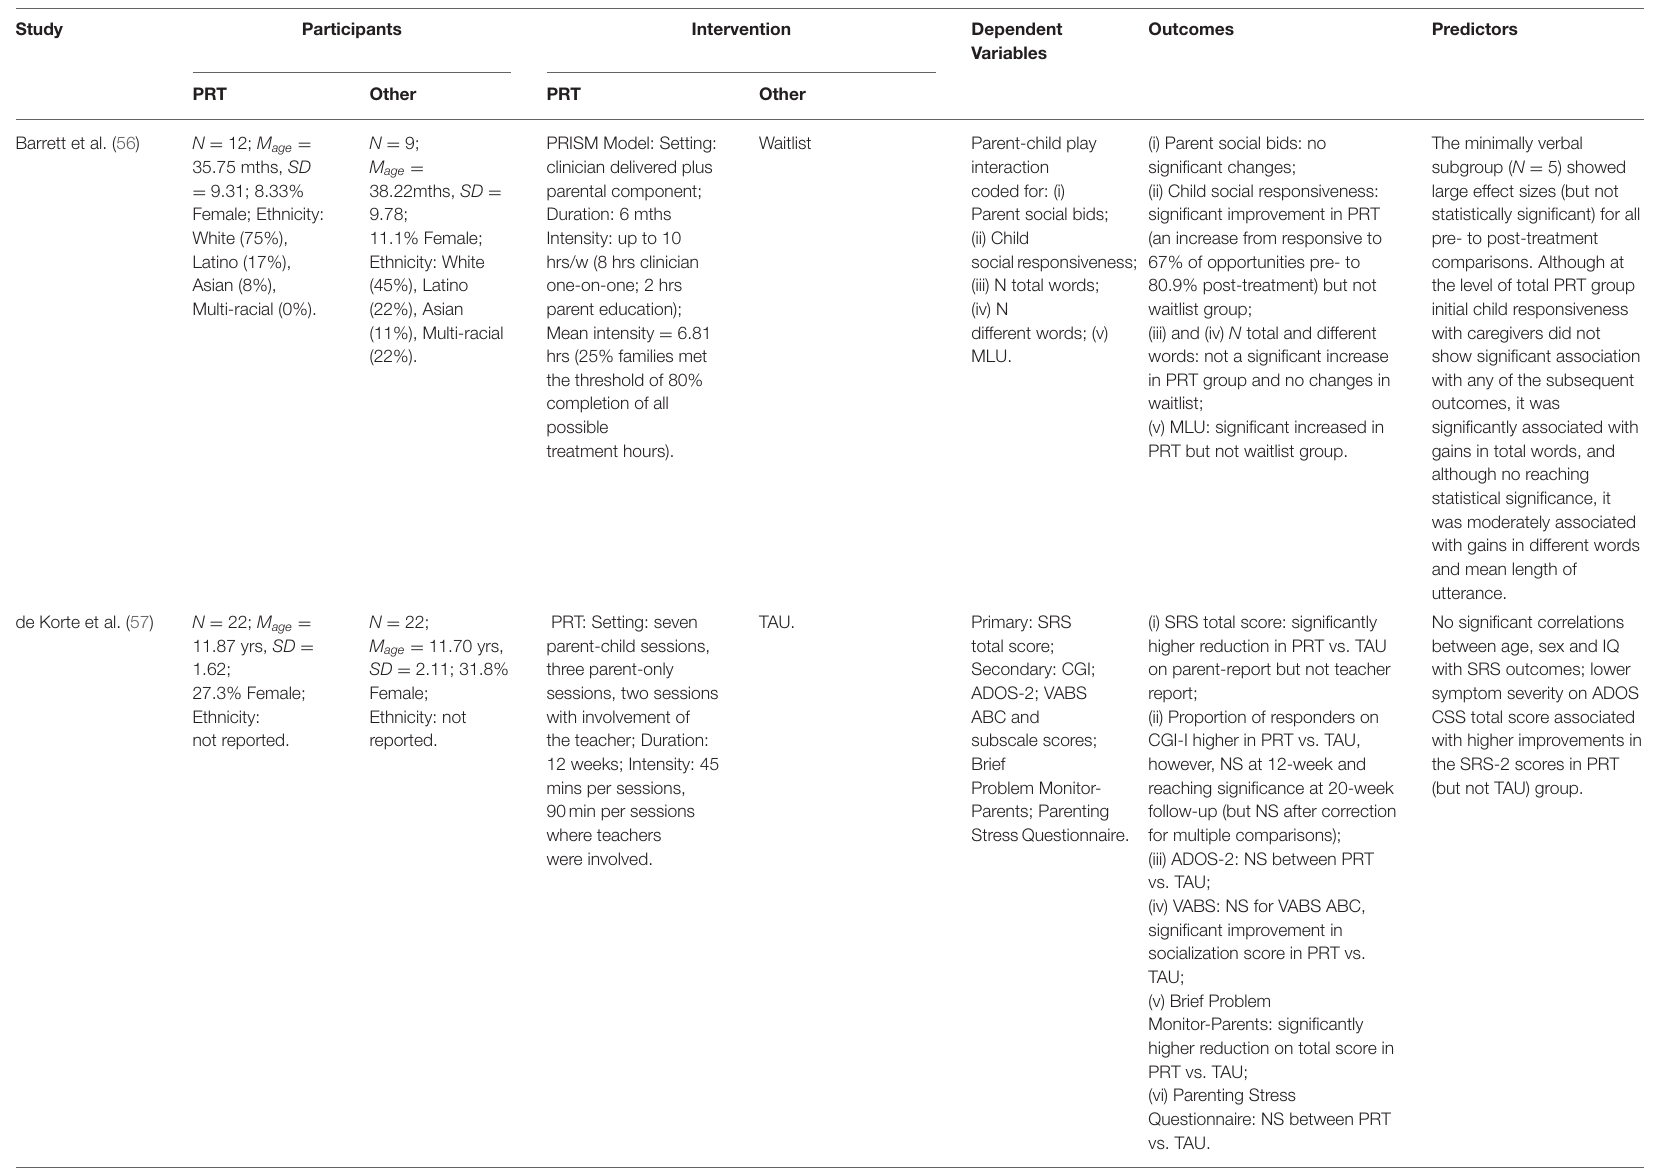
Outcomes Predictors Variables